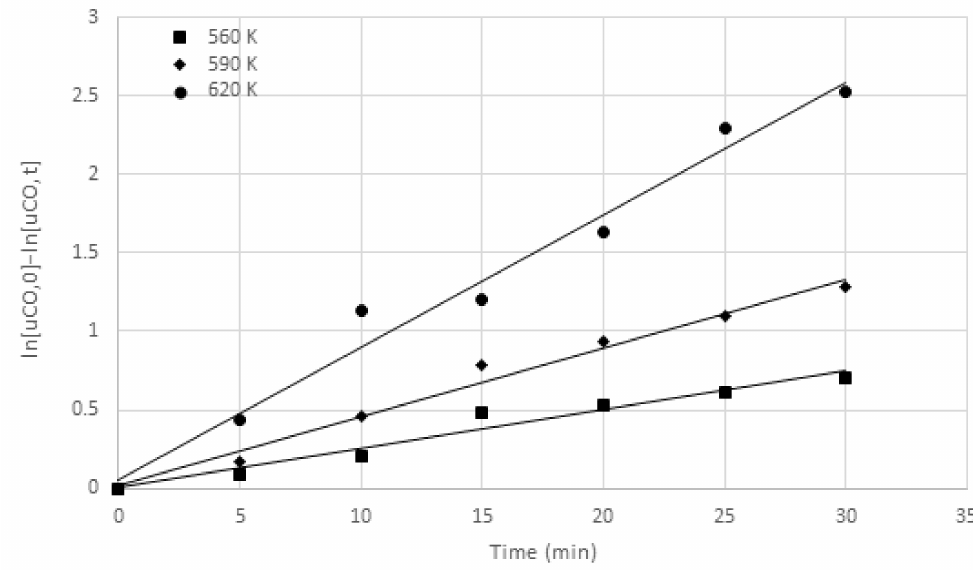
Figure 9. The plot of ln [uCO, 0] − ln [uCO, t] value against reaction time at the different reaction temperatures (Molar ratio 1:39 and P = 351 bar).